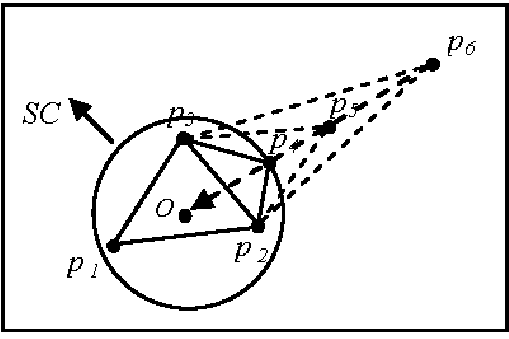
Figure 10. Vertexes located on the same line.